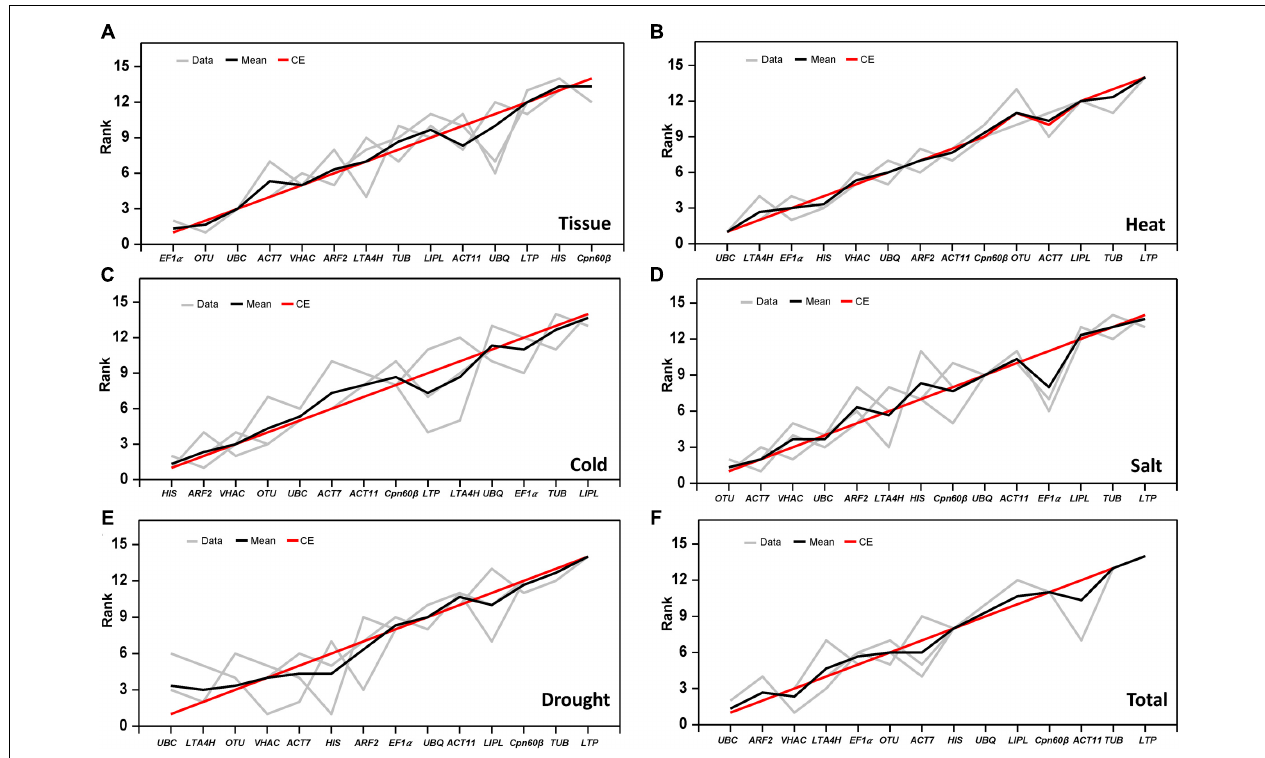
FIGURE 4 | Rank aggregation of gene lists using the Monte Carlo algorithm. The solution of the rank aggregation in tissue (A) , heat stress (B) , cold stress (C) , salt stress (D) , drought stress (E) , and total sample (F) are shown in a plot in which genes are ordered based on their rank position according to each stability measurement (gray lines). The mean rank position of each gene is shown in black lines, as well as the model computed by the Monte Carlo algorithm (red